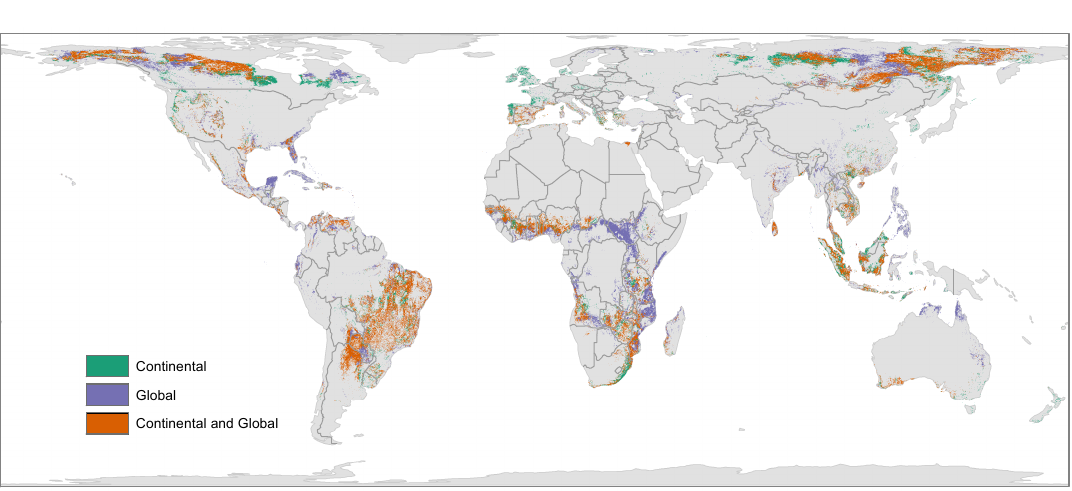
Figure 3. Areas of high transition potential (i.e., high risk of tree cover loss) in the global or regional model results, or